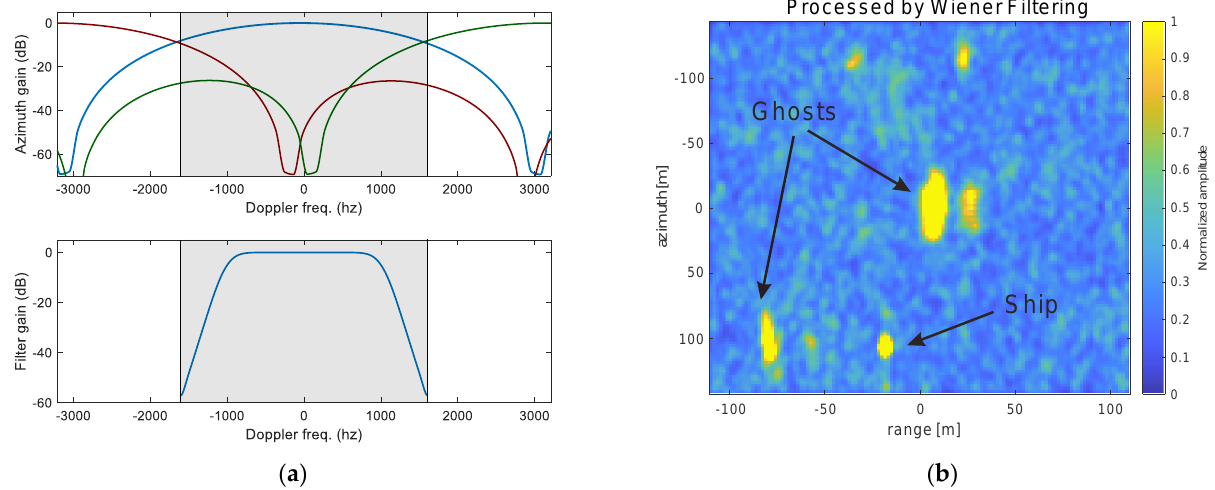
Figure 11. An example of ambiguity removal by the Wiener filter: ( a ) The AAP and left and right first replicas of TSX used in this study ( above ) and a transfer function of the Wiener filter derived from the AAP ( below ). The shaded region presents the azimuth bandwidth used for image formation. ( b ) The resulting image obtained by Wiener filtering. The area of interest is the same to that in Figure 7. Ghosts are not completely removed by the simple Wiener filtering so that it requires some additional processing steps. A comparison of ( b ) with the result obtained by the proposed method (bottom right in Figure 7) supports that the proposed approach does very effectively suppress ghosts while preserving vessels.